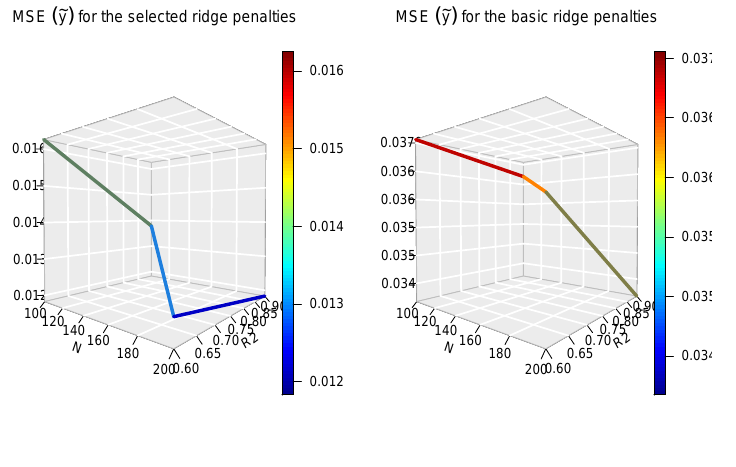
Figure 4. Average MSEs of MSE ( ˜ y ) for the defined selection of ridge